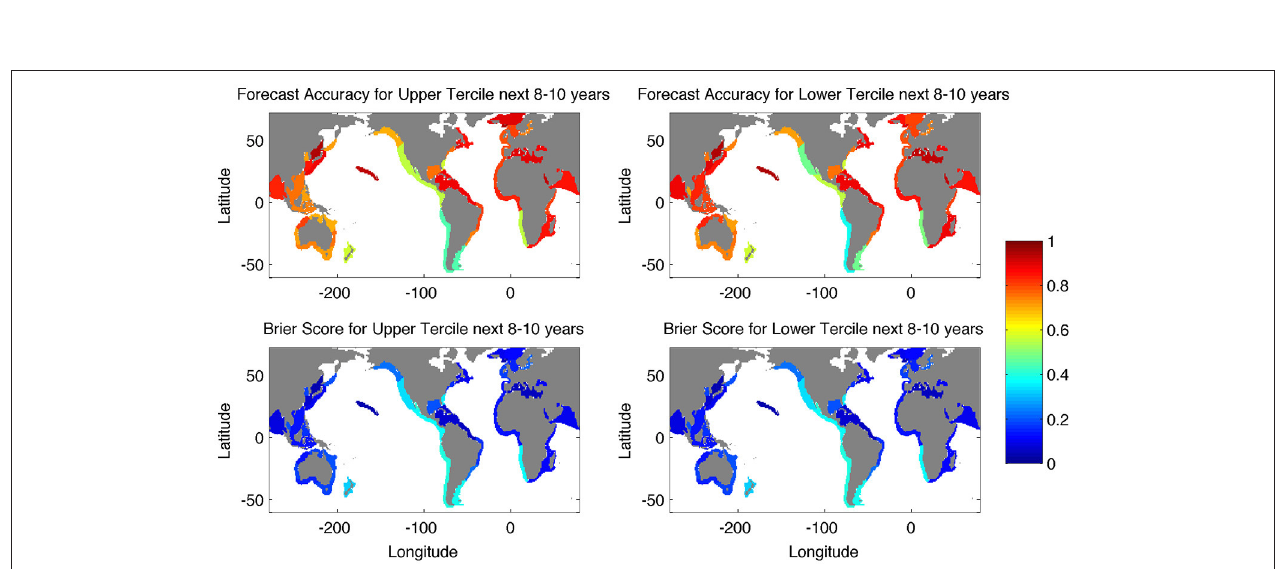
FIGURE 5 | Forecast accuracy (top) and Brier Score (BrS, bottom ) for upper and lower SST tercile predictions for a 8–10 years forecast. Forecast accuracy ranges between 0 and 1 (perfect skill). The BrS ranges from 0 (perfect score) to 1 (no skill).